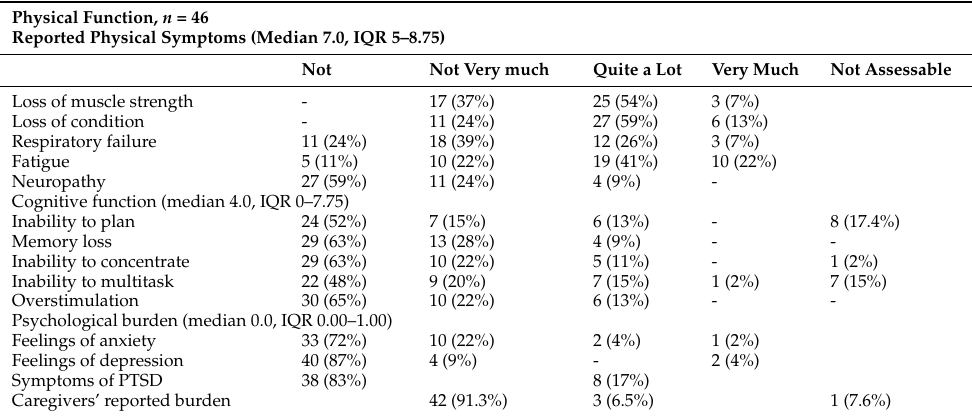
Table 2. Elements of post-intensive care syndrome (PICS) [9] scored by the STS Post-ICU COVID-19